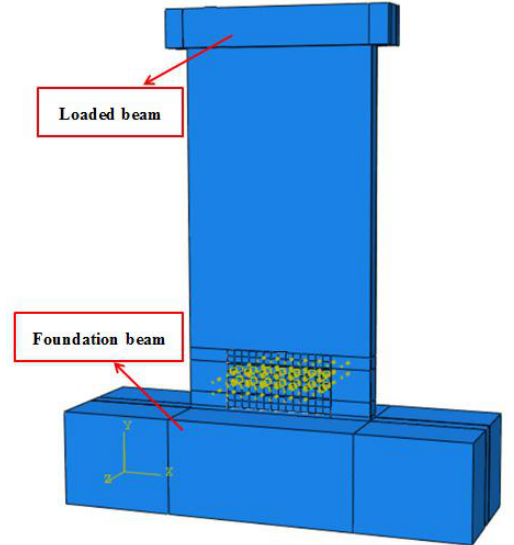
Figure 14. Numerical model. Appl. Sci. 2018 , 8 , x FOR PEER REVIEW